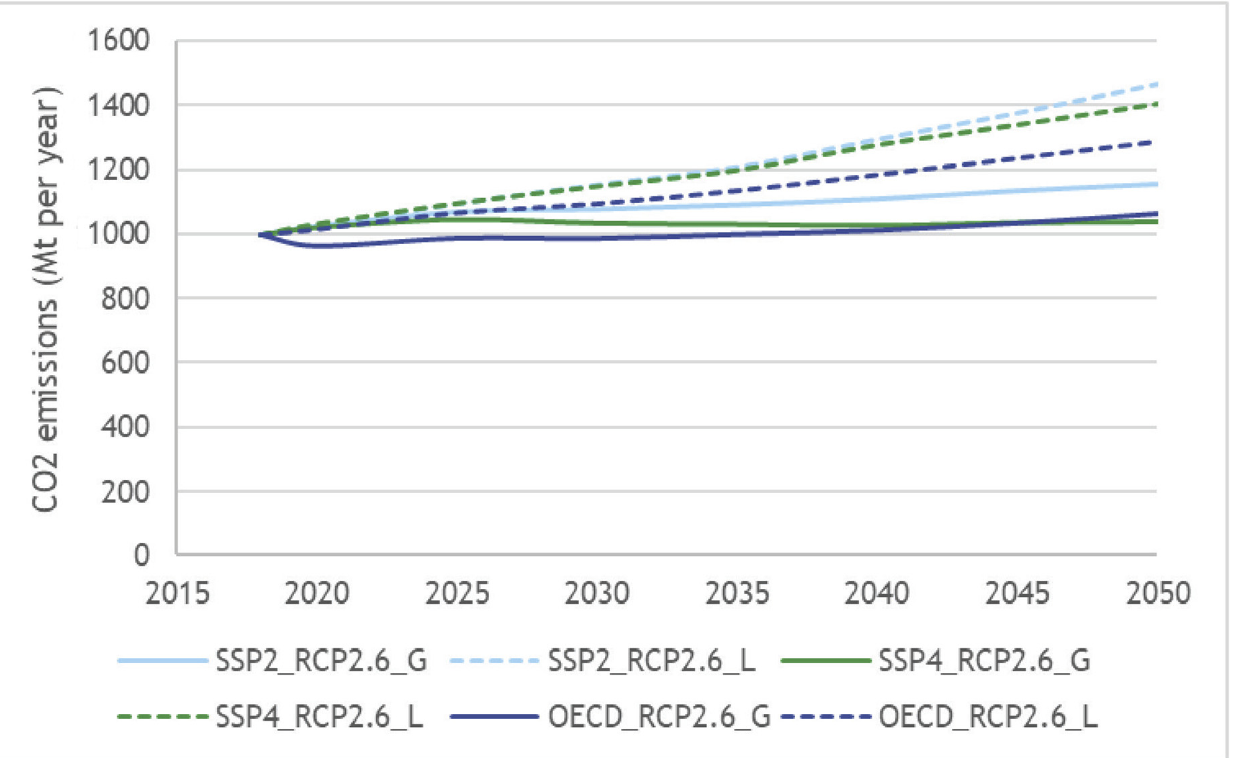
Figure 3. BAU forecasts of CO 2 emissions from ships under different scenarios. Source: IMO Fourth GHG Study [3].